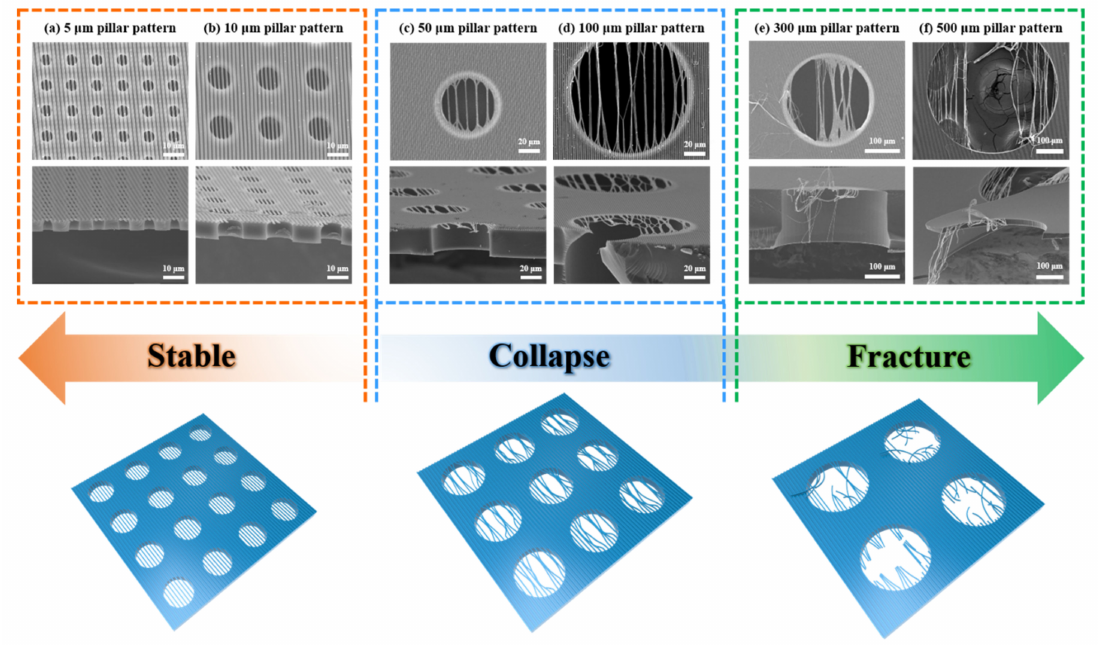
Figure 3. The stability criteria of the nano-line membrane monolithically constructed on the micro-aperture membrane. ( a – f ) SEM images and schematic illustration of the two-level polymeric membrane that consists of an 800 nm line layer and diverse supporting micro-pore-sized membranes. ( a ) The diameter of 5 µ m: State of the polymeric multi-layer membrane is stable. ( b ) The diameter of 10 µ m: State of the polymeric multi-layer membrane is stable. ( c ) The diameter of 50 µ m: State of the polymeric multi-layer membrane with some clustering of nano-bridges. ( d ) The diameter of 100 µ m: State of the polymeric multi-layer membrane with some clustering of nano-bridges. ( e ) The diameter of 300 µ m: State of the polymeric multi-layer membrane with torn and clustered nano-bridges. ( f ) The diameter of 500 µ m: State of the polymeric multi-layer membrane with torn and clustered